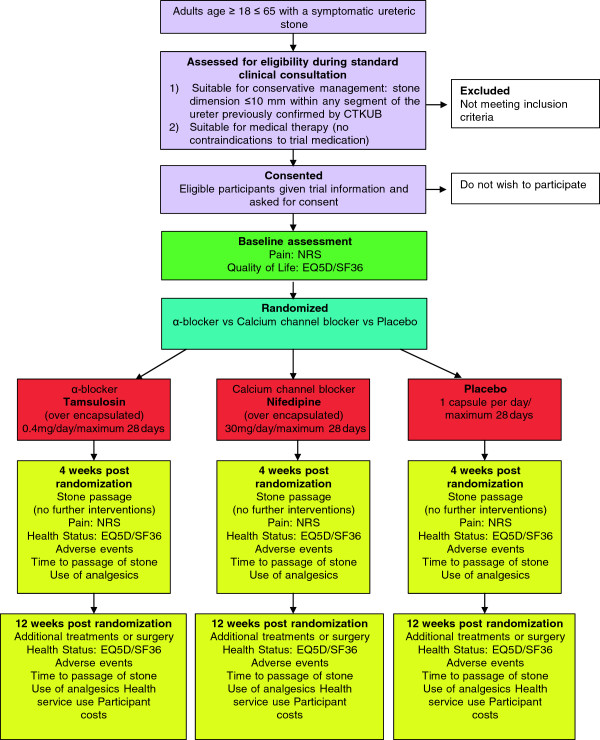
Flow diagram of the SUSPEND trial. CTKUB, Clinical tomography of the kidney, ureter and bladder; EQ5D, European Quality of Life, 5 Dimensions; NRS, numeric rating scale; SF36, Short Form (36) Health Survey.